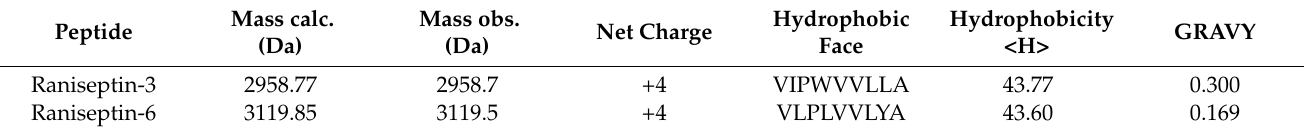
Table 1. Physicochemical properties of Raniseptins-3 and -6. Mass Peptide